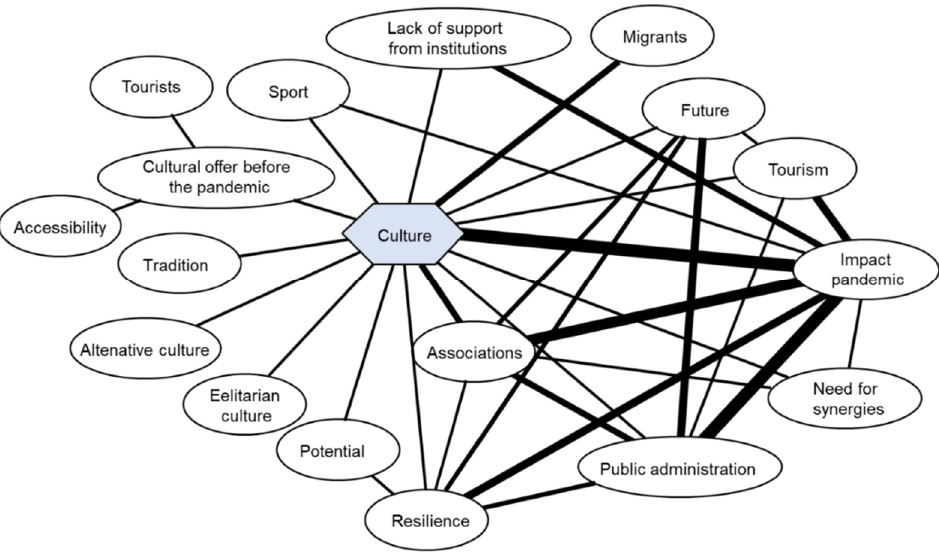
Figure 1. Culture in Merano (N = 14, expansion factor = 3).